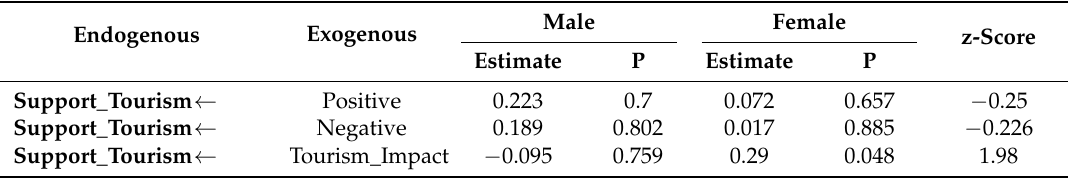
Table 4. Moderator